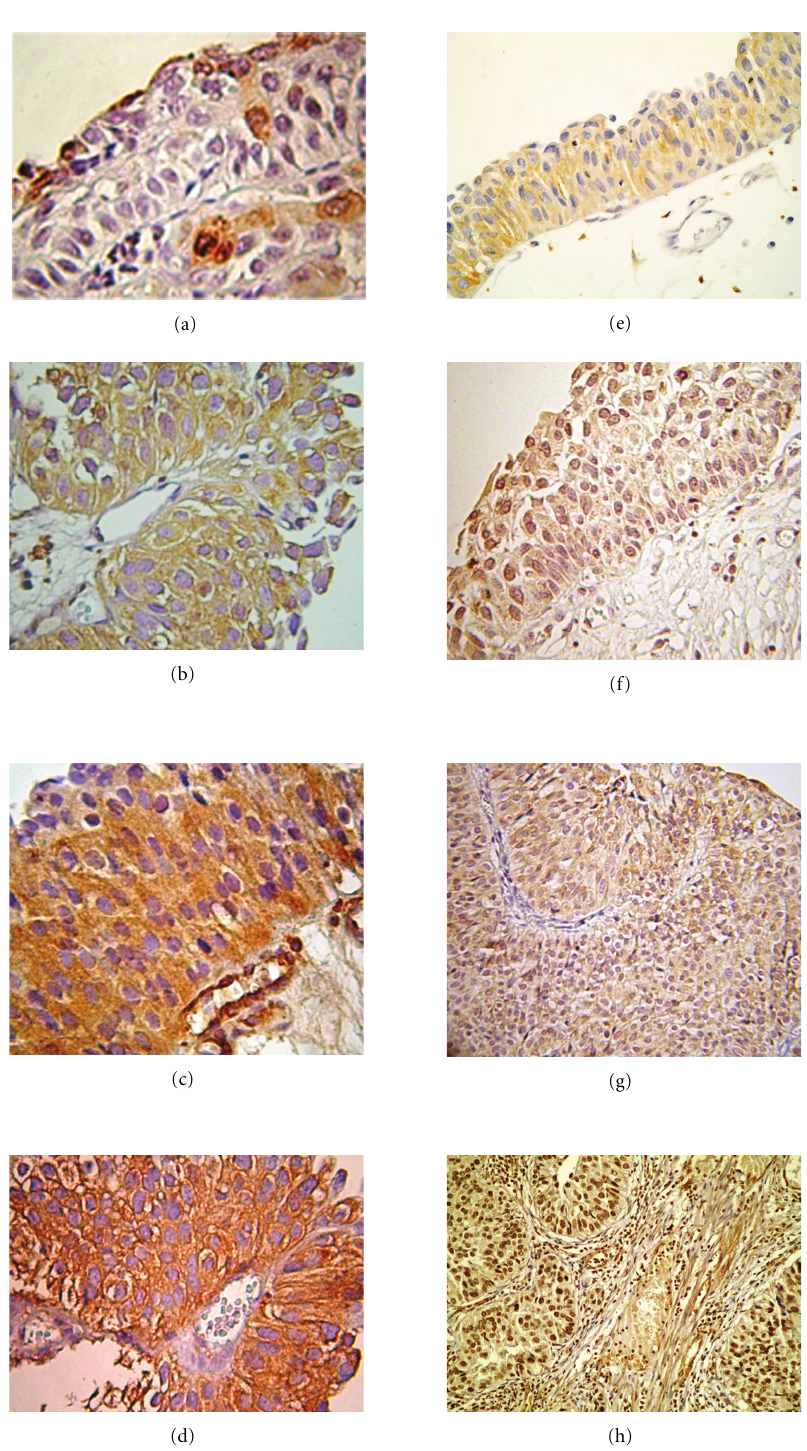
Figure 1: (a) and (e) Normal bladder epithelium. (a) Epithelial bladder cells exhibit no immunostaining for COX-2 (x200). (e) Strong positive cytoplasmic and negative nuclear expression for NF κ B (x200). (b) and (f) Well-di ff erentiated UC (Grade I) (b) Epithelial bladder cells exhibit weak positive cytoplasmic immunostaining for COX-2 (x200). (f) Moderate nuclear and strong cytoplasmic immunostaining for NF κ B (x200). (c) and (g) Moderately di ff erentiated UC (Grade II). (c) Epithelial bladder cells exhibit moderate cytoplasmic immunostaining for COX-2 (x200). (g) Strong nuclear and moderate cytoplasmic immunostaining for NF κ B (x200). (d) and (h) Poorly di ff erentiated UC (Grade III). (d) Epithelial bladder cells exhibit strong cytoplasmic immunostaining for COX-2 (x200). (h) Strong nuclear immunostaining for NF κ B